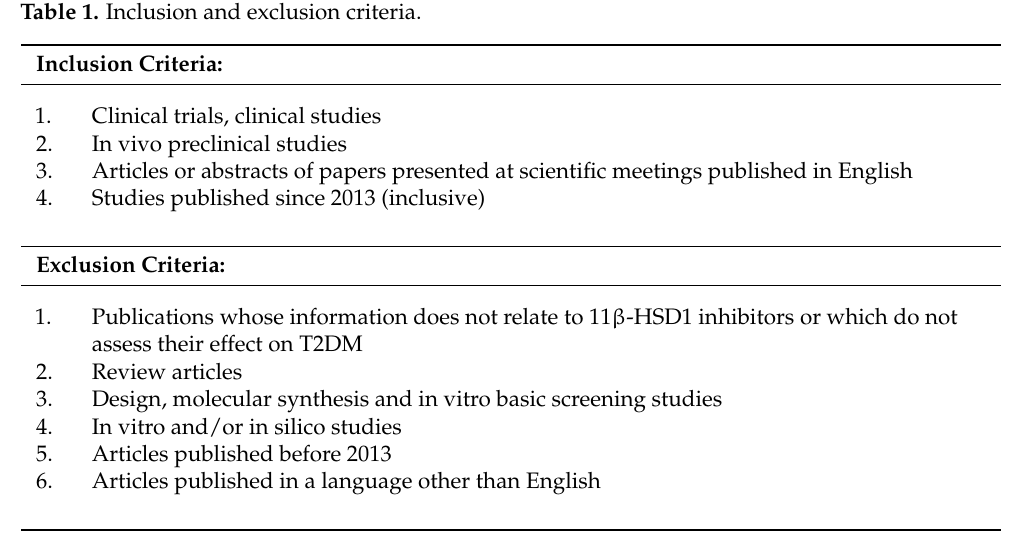
Experimental Drug